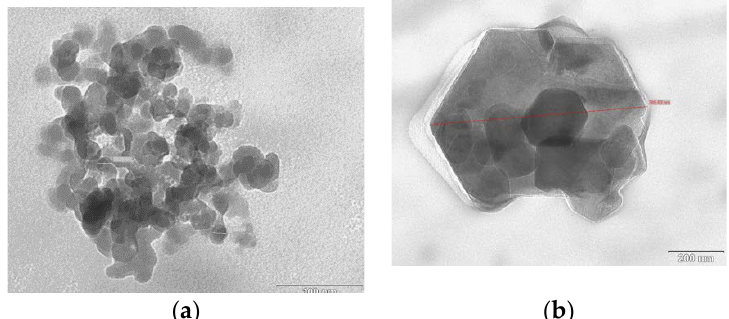
Figure 1. ( a ) The TEM of the prepared nanometer sized flame retardant magnesium hydroxide (nMg(OH) 2 ) nanoparticles with the typical size of 20 nm. The bar in the right lower corner represents 100 nm. ( b ) The TEM of the large Mg(OH) 2 particles. The bar in the right lower corner represents 200 nm.